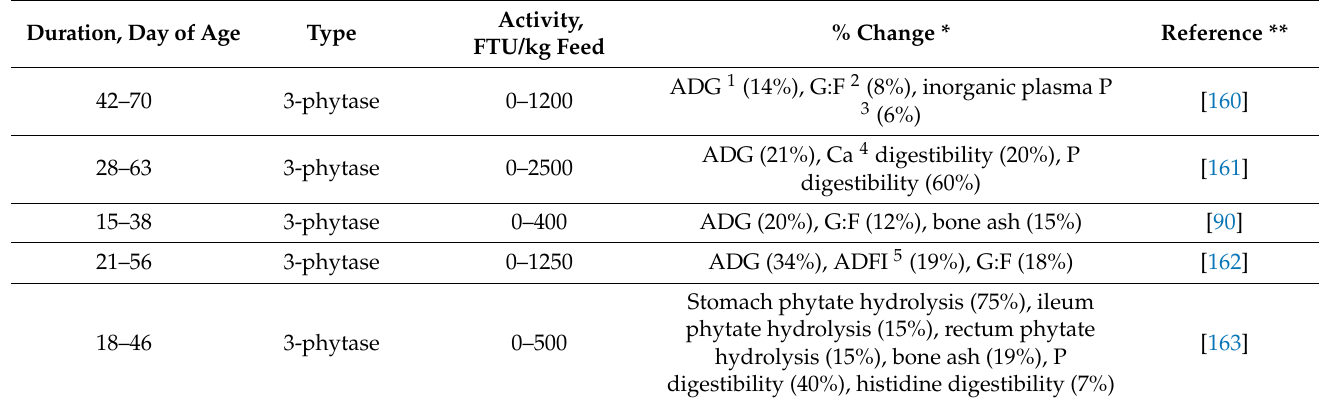
Table 2. A list of studies since 2000 describing effects of 3- and 6-phytase supplemented individually at different levels in diets for nursery